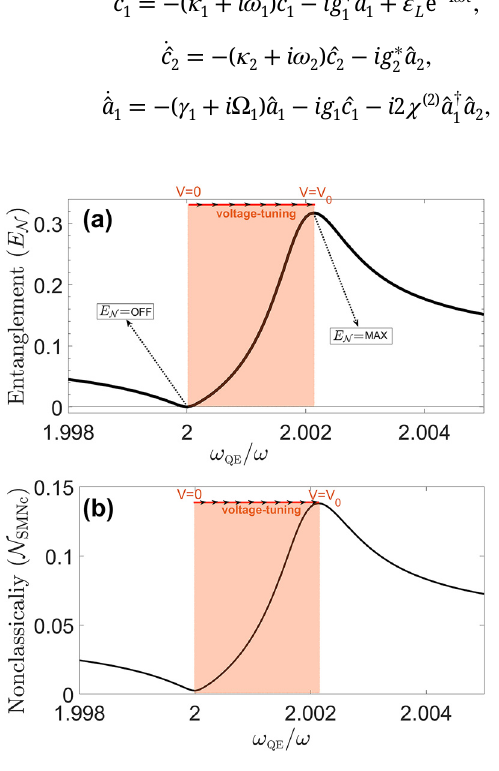
Figure 4: Generation of non-classicality and entanglement. (a) Degree of and 𝛿 b in the entanglement (log-neg) of the two output fields 𝛿 a out out = 2 𝜔 Figure 1. Voltage-tuning of the QE(s) level-spacing between 𝜔 QE ≈ 2.002 𝜔 turns off and on the entanglement, respectively. Thus and 𝜔 QE an undesired wave is not turned into non-classical. (b) Single-mode ̂ ) of the output mode b in units of log-neg [48, non-classicality (  SMNc out 64]. The right-going output can be used to generate entanglement via an integrated beam-splitter [44, 45,